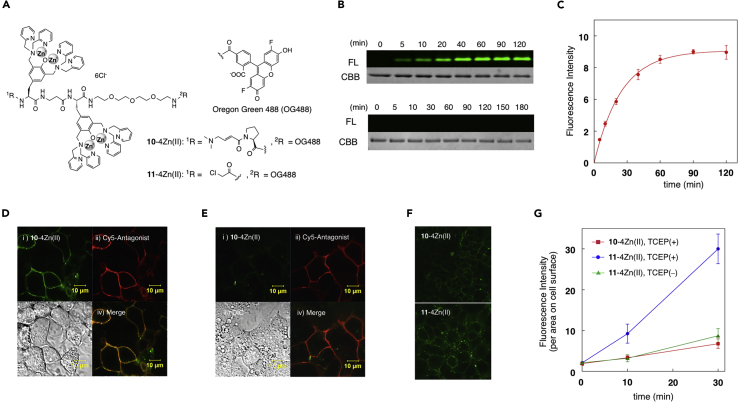
Fluorescence Labeling of helixD2-Tag-Fused Protein(A) Structures of the fluorescent Zn(II)-DpaTyr probes.(B) In-gel fluorescence (FL) and Coomassie Brilliant Blue (CBB) analysis of covalent labeling of MBP tagged with a helixD2-tag (upper panel) or CH6 tag (lower panel) by 10-4Zn(II). Labeling conditions: [tag-MBP] = 1 μM, [10-4Zn(II)] = 10 μM, 50 mM HEPES, 100 mM NaCl, 20 mM TCEP, pH 7.2, 37°C.(C) Time-trace plot of the fluorescence band intensity of the MBP labeled with 10-4Zn(II) (mean ± SD of triplicate experiment).(D and E) Fluorescence imaging of HEK293 cells expressing B2R fused with helixD2-tag (D) or CH6 tag (E) upon labeling with 10-4Zn(II). Labeling conditions: [10-4Zn(II)] = 4 μM, HEPES-buffered saline, pH 7.4, 37°C, 30 min.(F and G) (F) Fluorescence images of non-specific labeling on surface of HEK293 cells without expression of the tag-fused B2R. Labeling conditions: [10-4Zn(II) or 11-4Zn(II)] = 4 μM, HEPES-buffered saline, 20 μM TCEP, pH 7.4, 37°C, 30 min (G) Time-trace plot of the fluorescence intensity on the surface of HEK293 cells without expression of the tag-fused B2R (n = 10, mean ± SD).